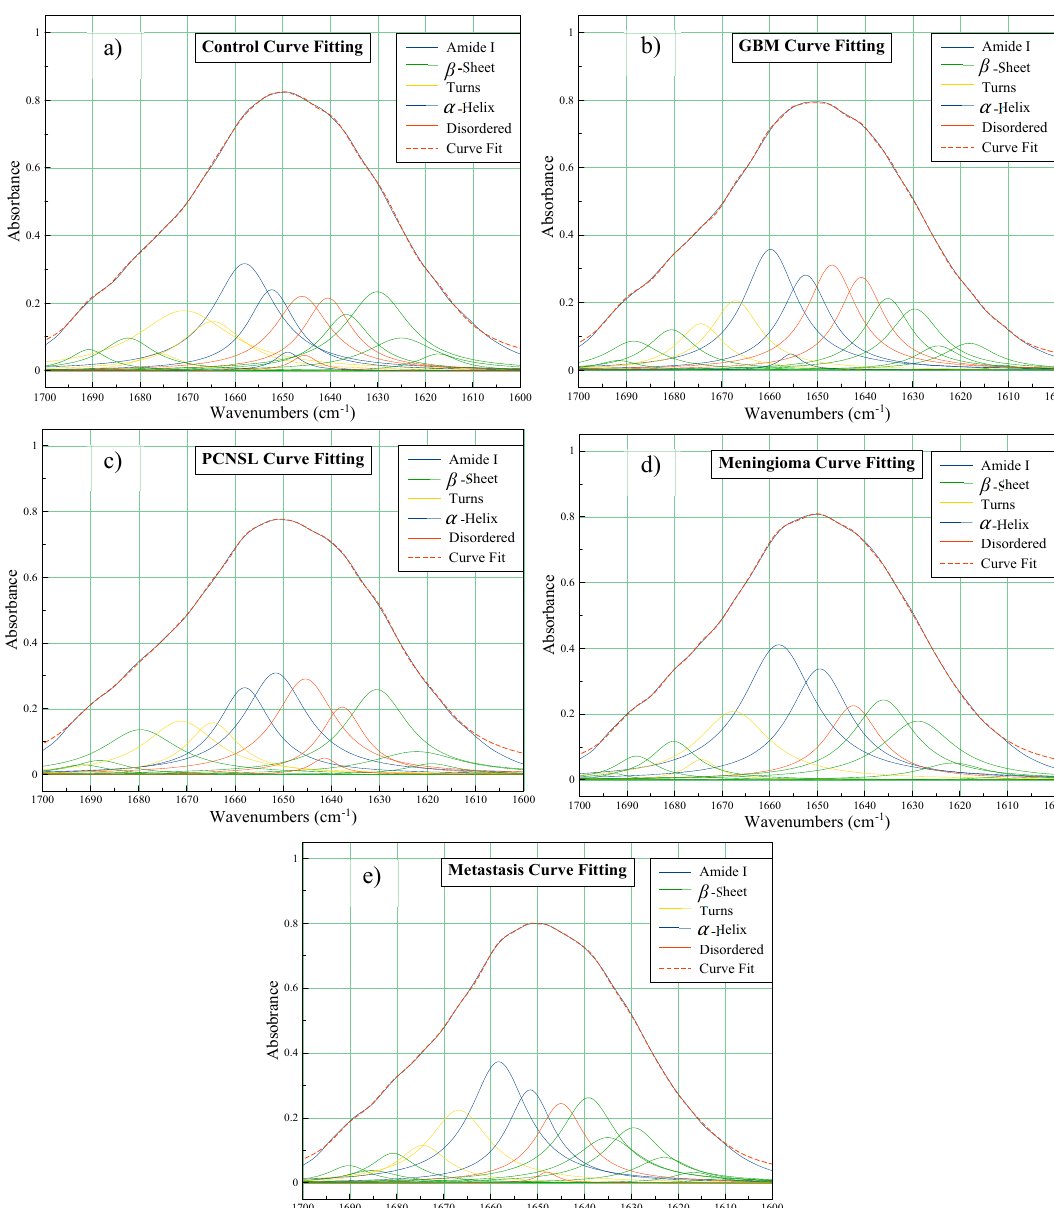
Figure 2. Amide I curve fitting showing the summation of resolved second derivative bands relative to the absorption profile for the: ( a ) control; ( b ) glioblastoma (GBM); ( c ) primary central nervous system lymphoma (PCNSL); ( d ) meningioma and ( e ) metastasis patient groups.